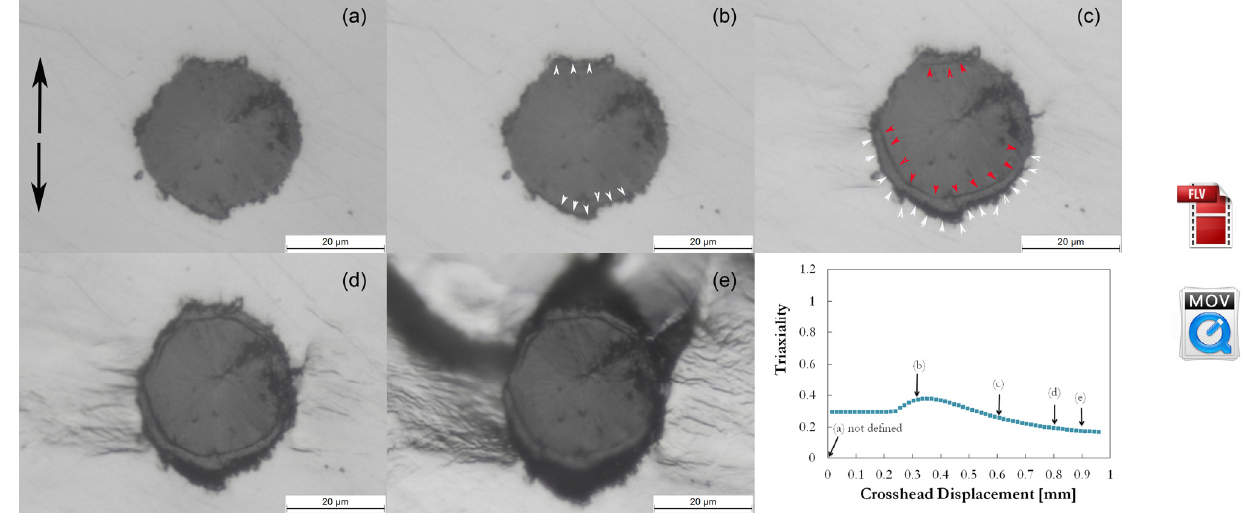
Figure 8: EN GJS700-2 ductile cast iron (Nodule 1, Fig. 5 and 6). Digital Microscope in situ lateral surface analysis performed on notched specimen (a-e); black arrows show the loading direction. Diagram: Triaxiality Factor - Crosshead displacement